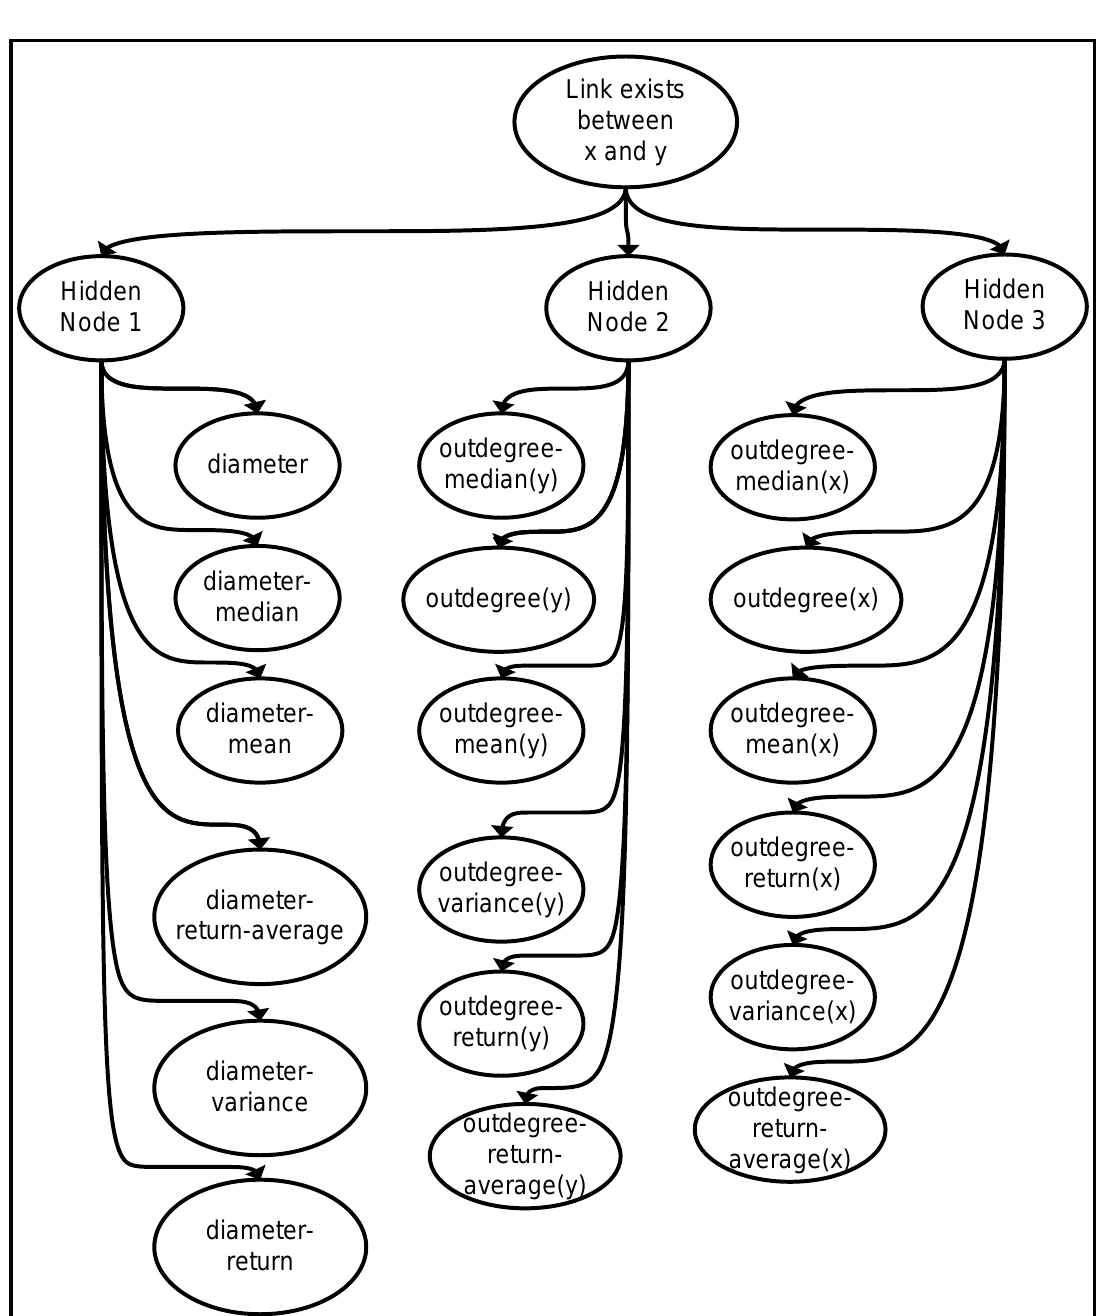
Figure 6. A Static Link Prediction Bayesian